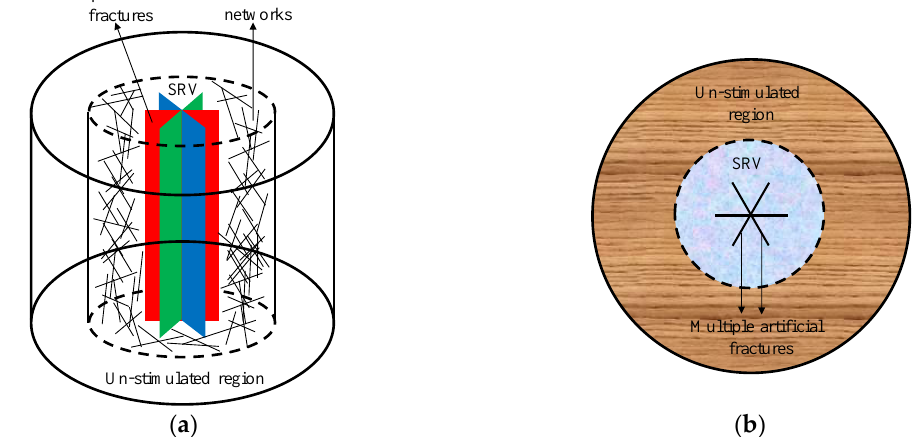
Figure 3. Schematic of a MFVW in a composite CBM reservoir with multiple artificial fracture wings: ( a ) Three-dimensional diagram and ( b ) Top view.